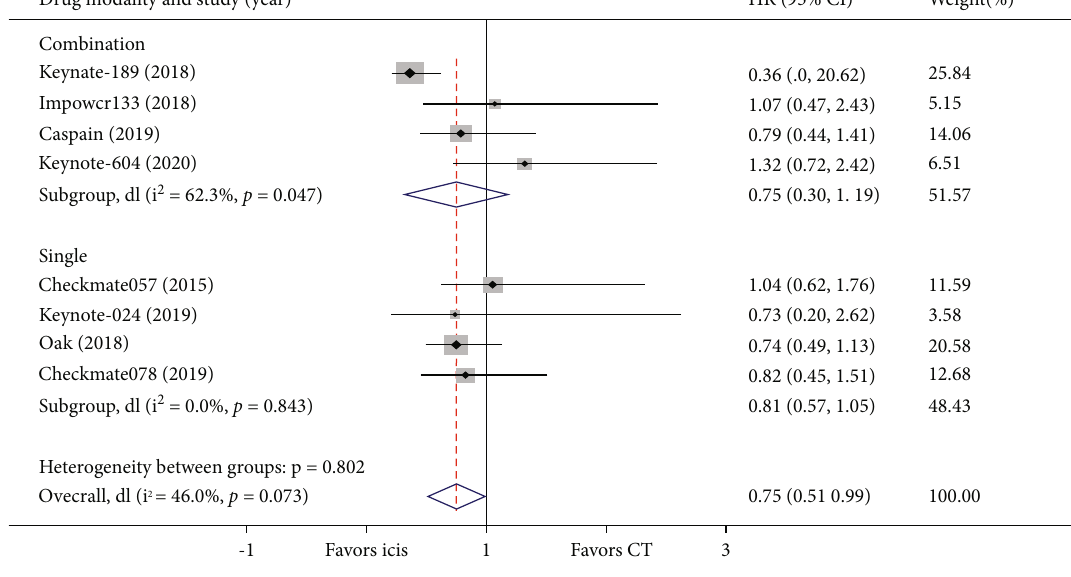
Figure 7: Subgroup analyses of OS by drug modality between the immune checkpoint inhibitors (ICIs) group and the chemotherapy (CT) group for lung cancer with BM.